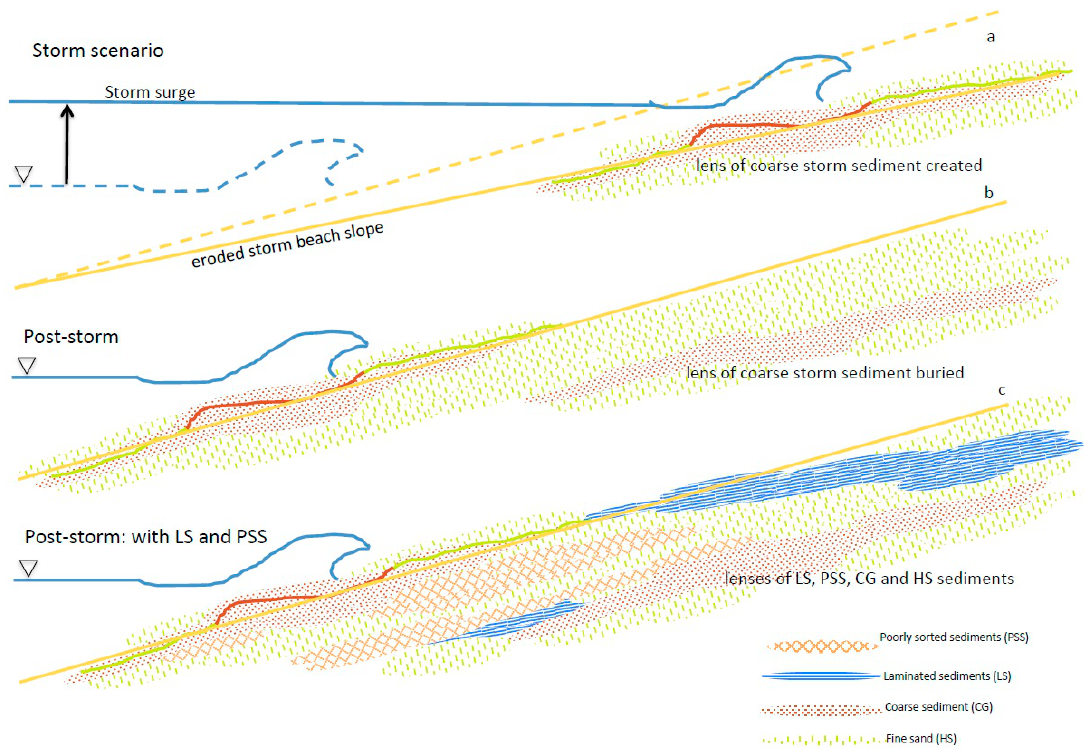
Figure 11. Illustration of storm deposition mechanism. ( a ) When water level is elevated and the beach has eroded, the shore break is translated onshore and the three processes (Figure 10) act in that location to create a lens of coarse sediment. ( b ) When the storm recedes and the beach recovers, that coarse lens is preserved. ( c ) Rather than only two sand units (fine and coarse), including the four sedimentary units (Figure 4) is a natural extension of the conceptual model and gives realistic pictures of beach stratigraphy.